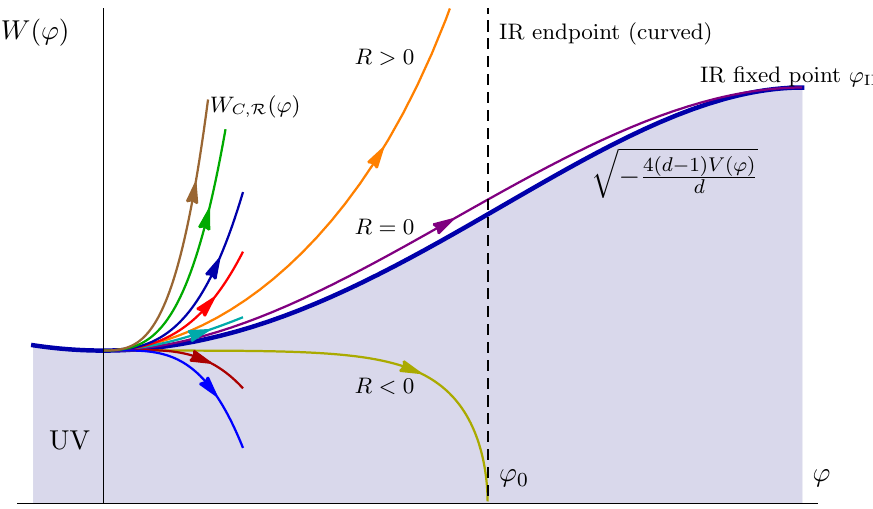
Figure 4 . Sketch of di(cid:11)erent solutions for W ( ’ ), for various curvatures, in a theory with a UV and an IR (cid:12)xed point at ’ = 0 and ’ = 1, respectively. Of all the solution starting from the UV (cid:12)xed point, three are followed to the IR endpoint, which can be at the conformal (cid:12)xed point ( R = 0) or an intermediate point 0 < ’ 0 < 1. For R ( (cid:16) ) (cid:21) 0 the shaded region below the blue curve cannot be